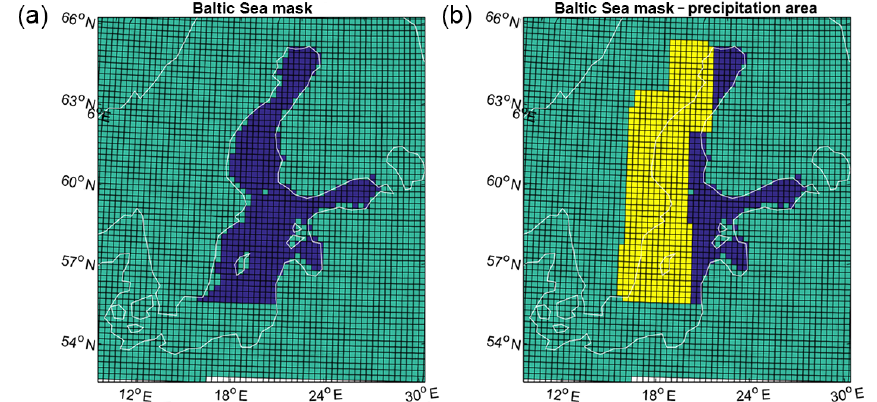
Figure 2. Baltic Sea area (in blue, a ) and the precipitation area (in yellow, b ) considered for the criteria for the selection of days with convective snow band conditions (compare to Table 1). Table 1. Criteria for the selection of days with moderate to favourable atmospheric conditions for convective snow bands. The Baltic Sea area and precipitation area are defined in Fig. 2. Region Parameter Weak criteria Strong criteria Baltic Sea